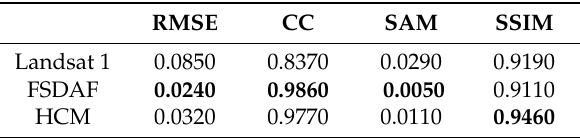
Figure 10. Comparison of FSDAF and HCM prediction results. ( a ) is the Landsat image at t 2 ; ( b ) and ( c ) are the prediction images using FSDAF and HCM, respectively. Table 7. Comparison of FSDAF and HCM for the synthetic